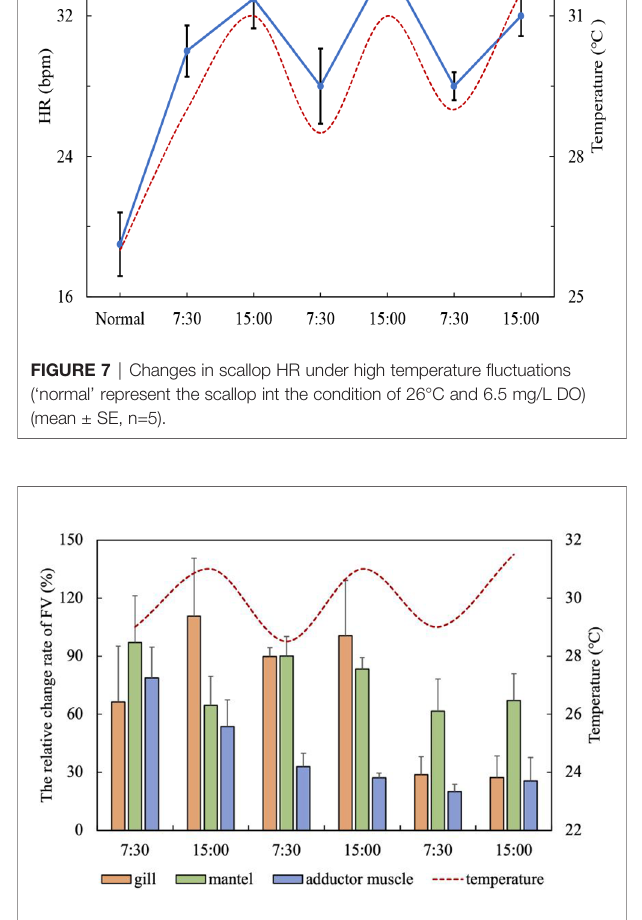
FIGURE 8 | The relative change rate of FV in the gill, mantle and adductor muscle under high temperature fl uctuations (mean ± SE, n = 5).